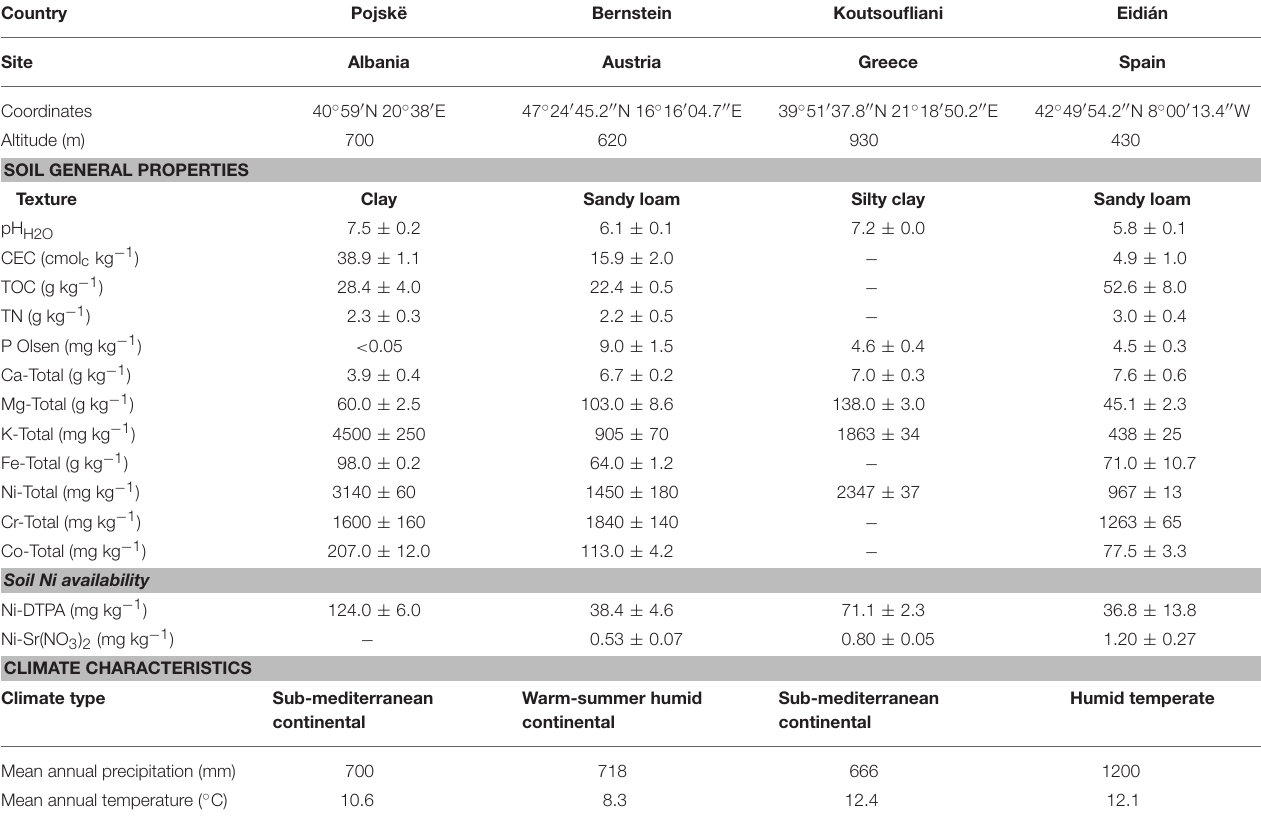
TABLE 2 | Soil physicochemical and climate characteristics of the field sites included in the Life-Agromine network (mean values ± SE).